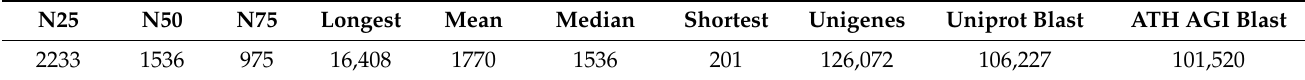
Table 2. Assembly statistics for the Brassica juncea L.